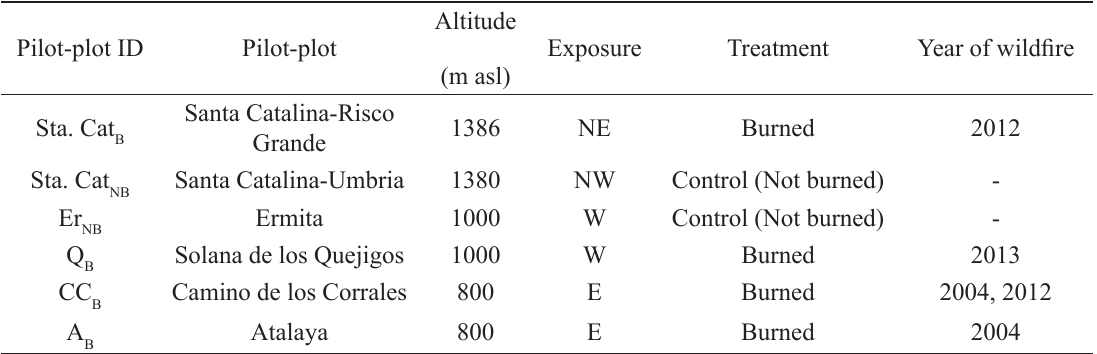
Table 1. Location, altitude, and fire incidence details of the permanent pilot-plots established in the present study. Abbreviations in the subscript are as follows: B, burned, NB, not